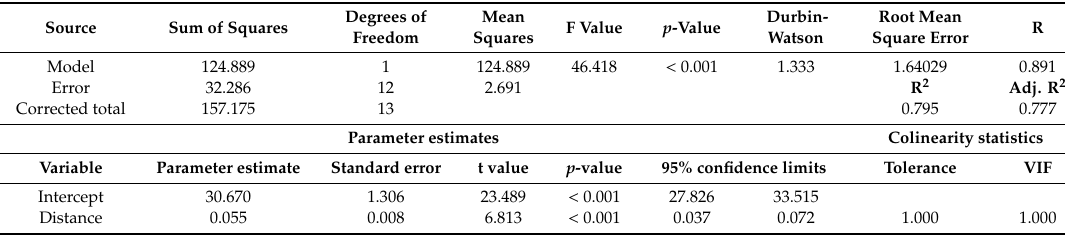
Table 5. Analysis of the Variance of the model of Equation 2.